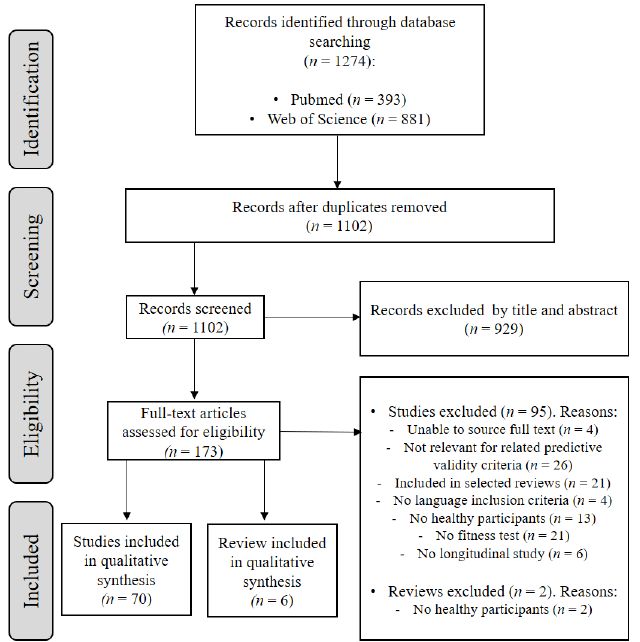
Figure 1. Flow chart of the study selection process.